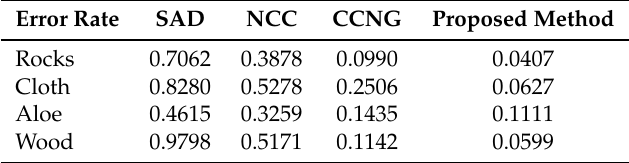
Table 2. Quantitative disparity evaluation with ground truth (error tolerance = 2).